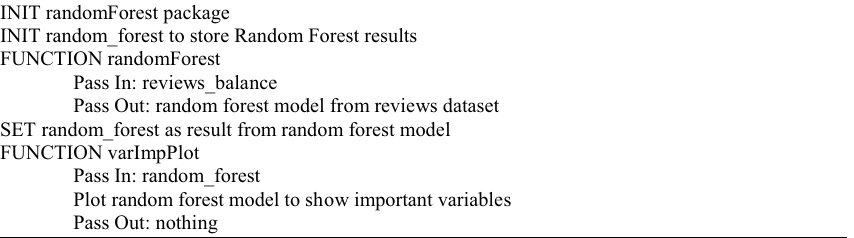
Table 7 Pseudocode to execute the Random Forest Model and plot essential variables based on Random Forest algorithm INIT randomForest package INIT random_forest to store Random Forest results